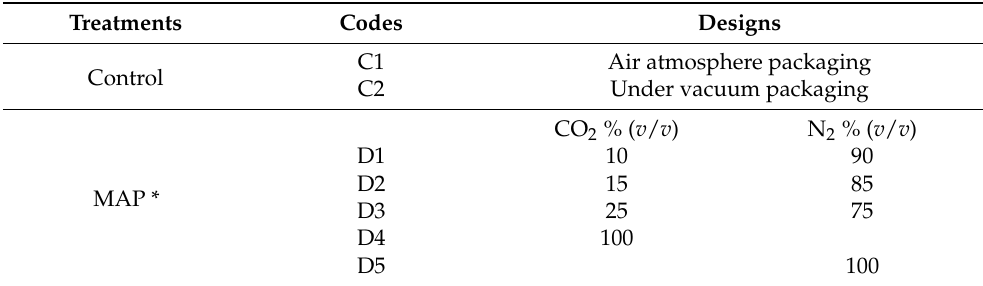
Table 1. Experimental modified atmosphere packaging designs of